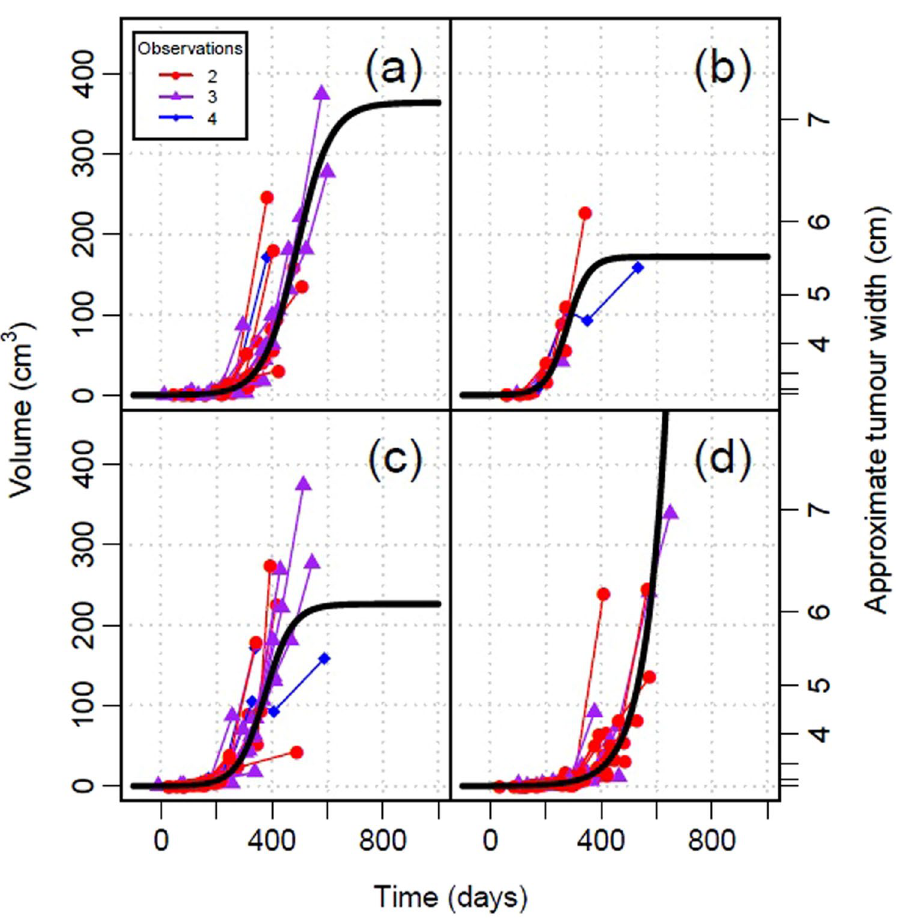
Figure 1. Best-fit maximum likelihood models for given tumour characteristics: ( a ) diploid, ( b ) tetraploid, ( c ) dermal and ( d ) mucosal. Volume versus time line plots for each tumour are overlaid in relation to the predicted growth curve based on their maximum-likelihood initial conditions. On each plot, time 0 represents the point at which the tumour reaches 0.125 cm 3 in volume.